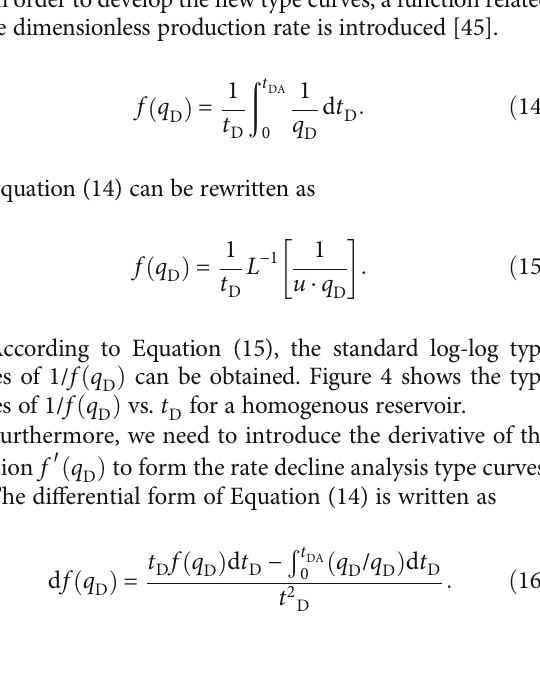
Period I is the skin e ff ect and early transition stage. The curves of q D , 1/ f ð q D Þ , and 1/ f ′ ð q D Þ vs. t D exhibit a downward line.